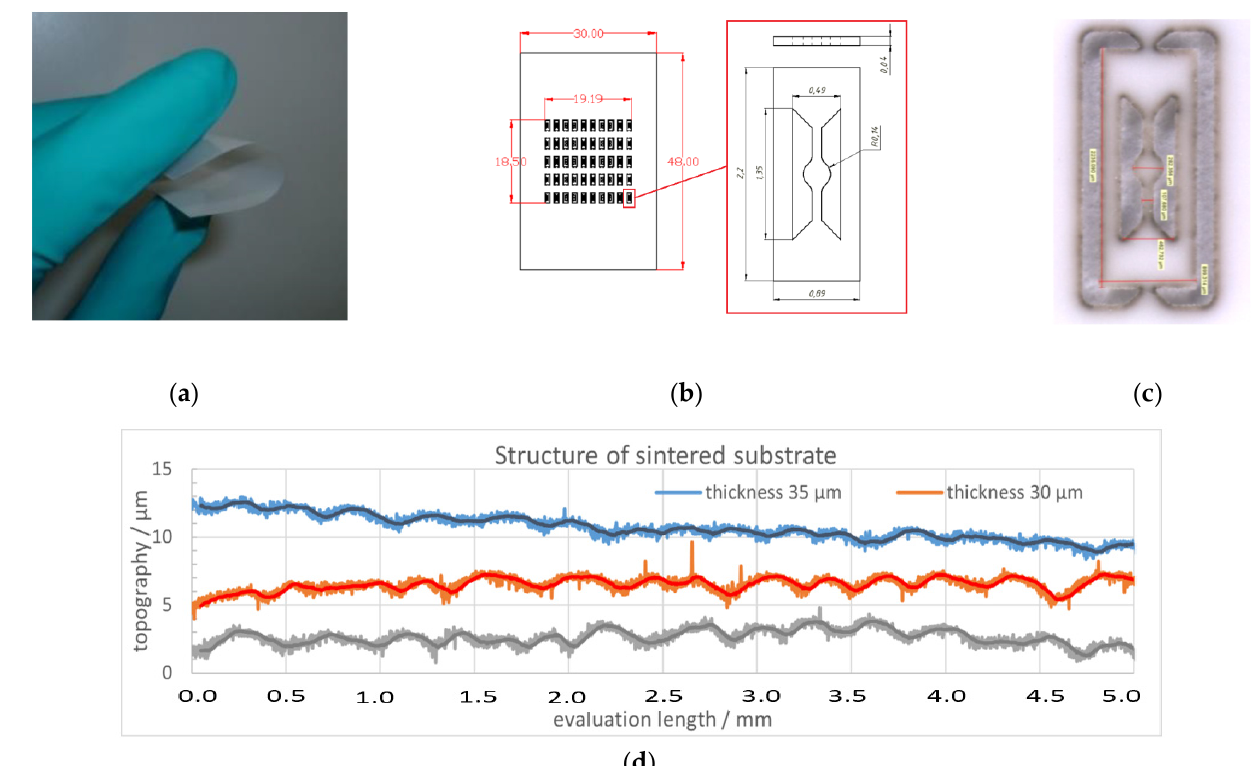
Figure 2. The following displays an ultra-thin zirconium oxide membrane: ( a ) Demonstration of flexibility of 30 µm (5 × 5 cm 2 ) thin 3YSZ substrate, ( b ) sketch of 3YSZ membranes for cutting by laser to single microhotplate chips; ( c )optical view of a 3YSZ microhotplate chip attached to a ceramic frame; and ( d ) the surface roughness measurement of the YSZ membrane after sintering.